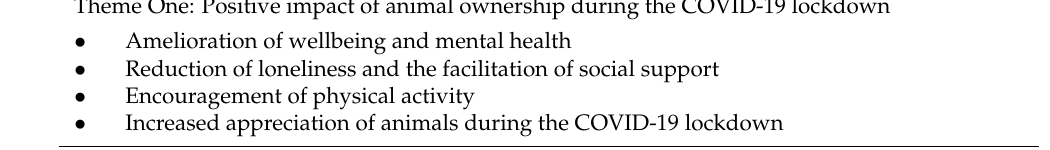
Table 2. Themes and associated